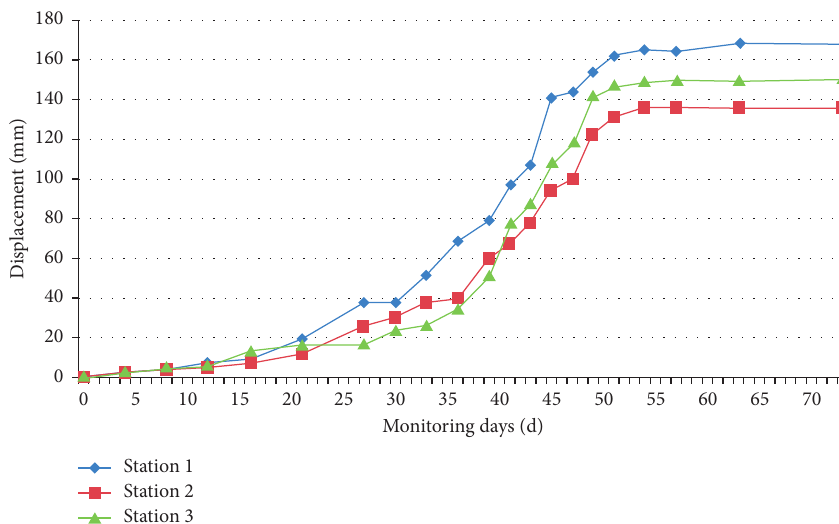
Figure 17: The displacement monitor of the roof and